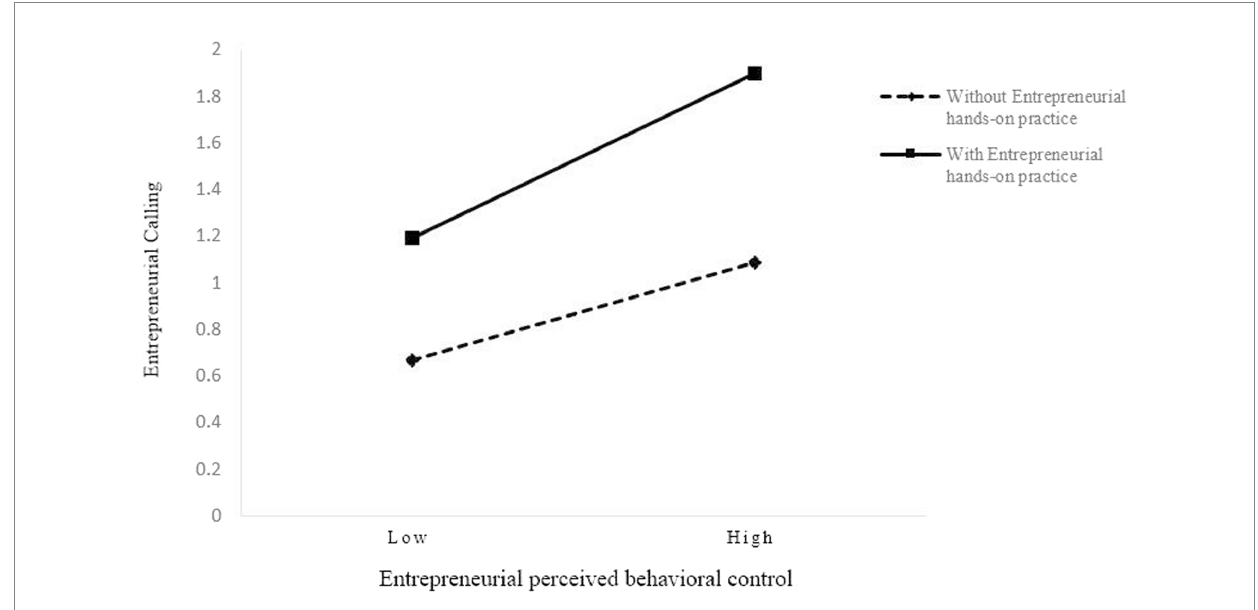
FIGURE 3 Entrepreneurial hands-on practice as a moderator between entrepreneurial perceived behavioral control and entrepreneurial calling.